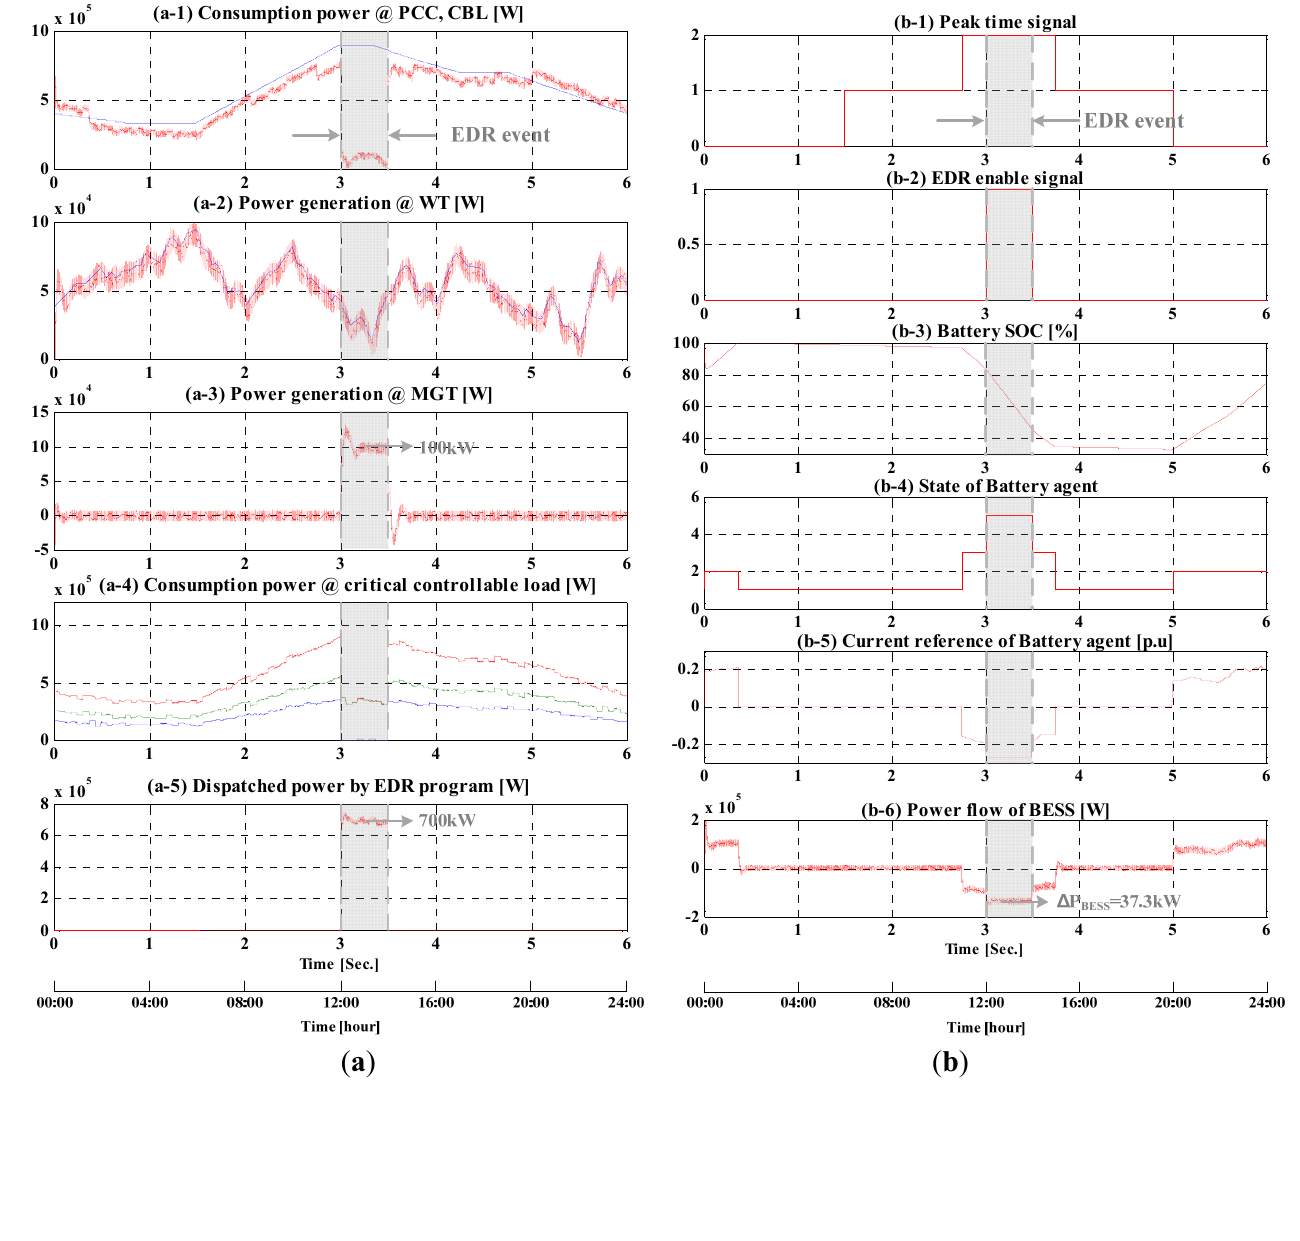
Figure 17. Simulation results in case 3. ( a ) Power flow of microgrid; ( b ) Signal process of BESS